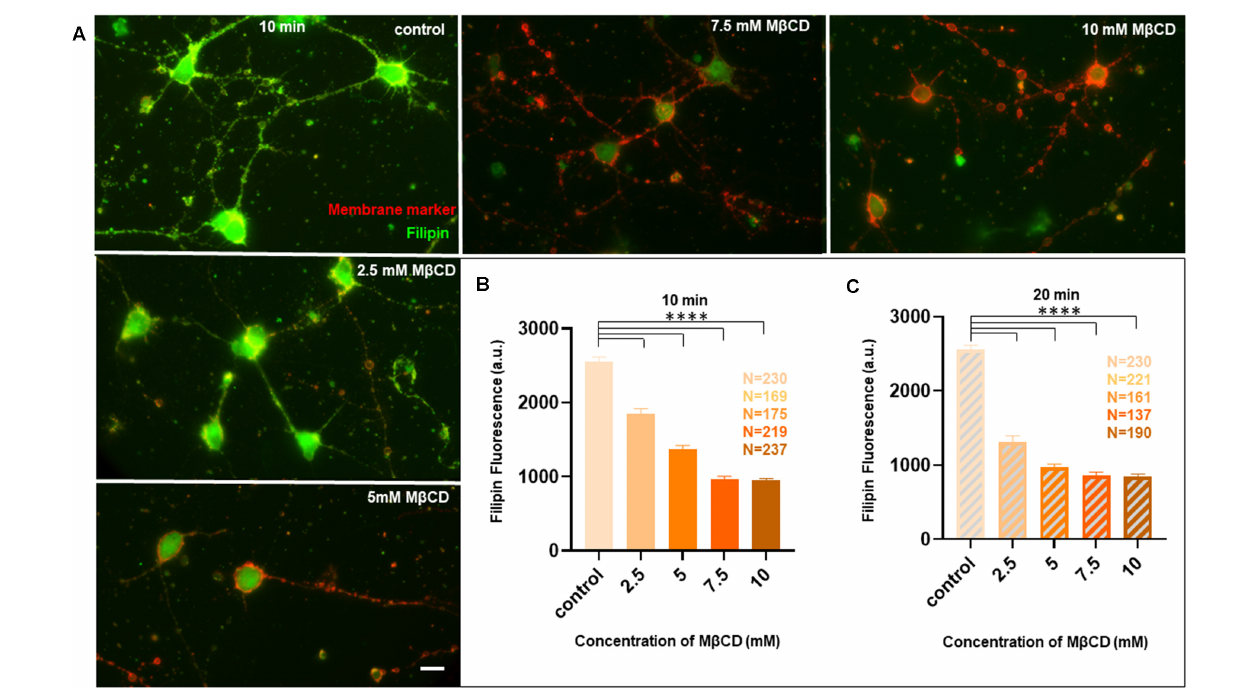
FIGURE 5 | Membrane cholesterol labeling by Filipin III shows altered fluorescence, dependent upon dosage and duration of cholesterol sequestering, consistent with neuro-morphological defects. Neurons at DIV1 were transiently treated with varying concentrations of M β CD for 10 min and 20 min to sequester cholesterol. The cells were labeled with a lipid raft membrane marker (red) and Filipin III (green) and imaged at DIV3. (A) A gallery of control and cells treated with varying concentrations of M β CD for 10 min is presented. Both channels in all panels are thresholded with the same values for comparison. (B) Represents the absolute fluorescence of Filipin III for cells treated with varying concentrations of M β CD for 10 min. (C) Represents the absolute fluorescence of Filipin III for cells treated with varying concentrations of M β CD for 20 min. Fluorescence of Filipin III marks unesterified cholesterol on the membrane. Cholesterol sequestering decreased Filipin III fluorescence, but the effect was severe for 20 min compared to 10 min of cholesterol perturbation, consistent with the corresponding neuro-morphological defects observed. N denotes the number of cells from three independent cultures. One-way Anova was performed to test the significance of the difference between the means. ∗∗∗∗ p < 0.0001. Scale bar indicates 20 µ m.